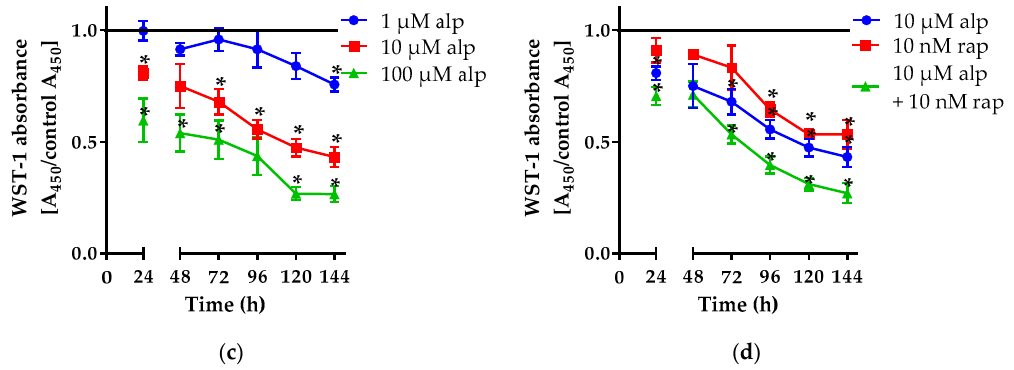
Figure 1. WST-1 cell viability assay after alpelisib or alpelisib+rapamycin treatment of lipoma cell cultures from three PTEN Hamartoma Tumor Syndrome (PHTS) patients (LipPD1-3) and two PIK3CA-related overgrowth spectrum (PROS) patients (Lip3-4): ( a ) 72 h alpelisib treatment reduced cell viability at concentrations ≥ 10 µM in all tested cell cultures; ( b ) a 72 h combined treatment with alpelisib and rapamycin further decreased cell viability; ( c ) 24–144 h treatment of PTEN-haploinsufficient LipPD1 cells at 1 to 100 µM alpelisib reduced cell viability; ( d ) 24–144 h combined treatment with alpelisib and/or rapamycin further decreased viability. Fold over solvent control (black line), n = 3, * p ≤ 0.05.